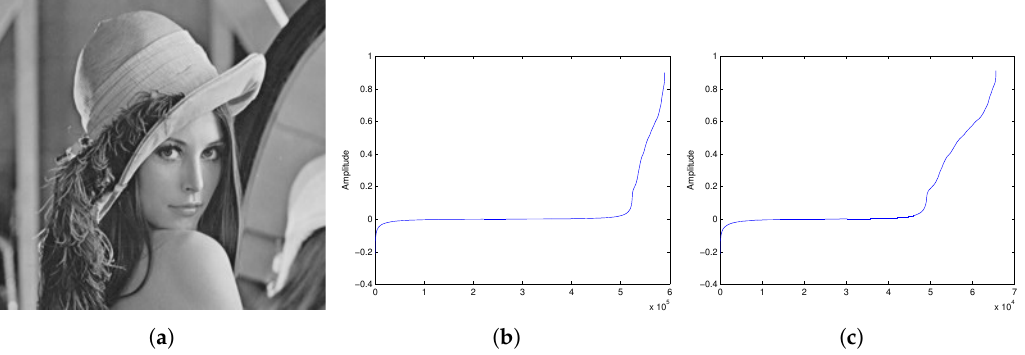
Figure 1. Comparation of framelet and wavelet decomposition. ( a ) the lena image; ( b ) the sorted framelet coefficients at level 1; ( c ) the sorted wavelet coefficients at level